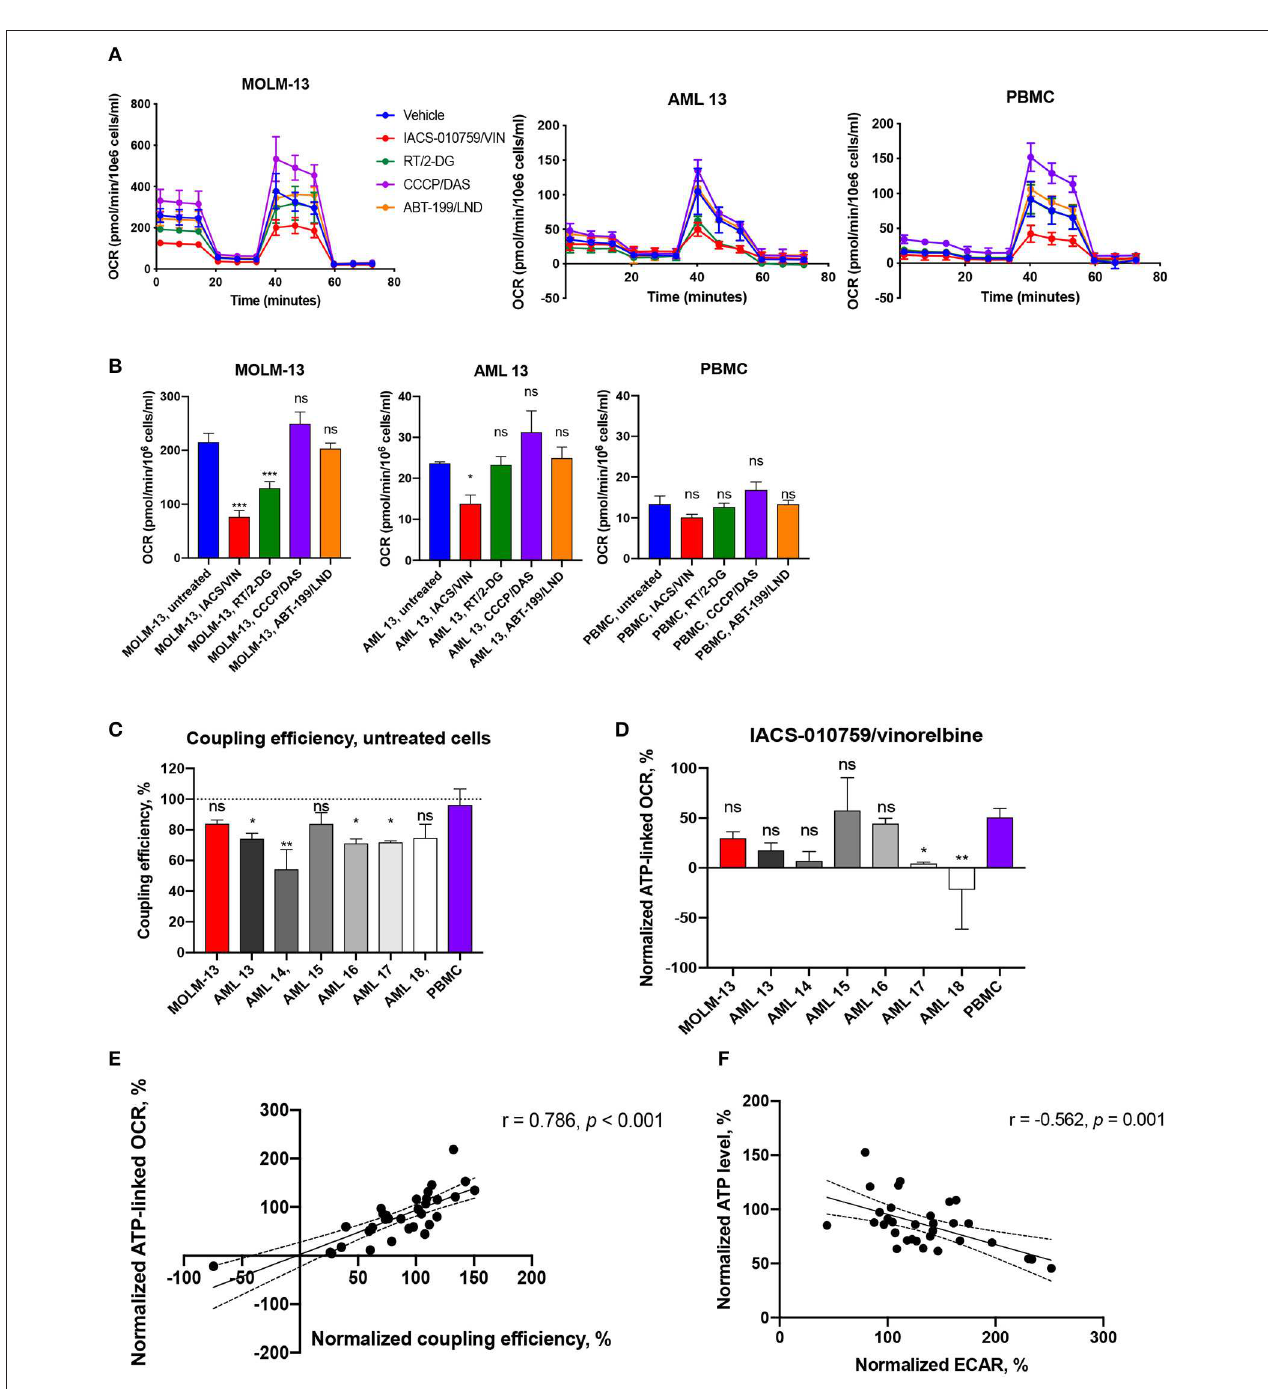
FIGURE 7 | Bioenergetic profiling of immortalized and primary AML cells and healthy PBMCs after treatment with selected drug combinations. (A) Oxygen consumption rate (OCR) was measured using a Seahorse flux analyzer. OCR measured in cells either untreated (blue) or treated with IACS-010759 25 nM/vinorelbine 10nM (red), rotenone 50 nM/2-deoxy-D-glucose 50 µ M (green), CCCP 200 nM/dasatinib 50nM (purple), or ABT-199 1.3 nM/lonidamine 50nM (orange) for 2h. One representative replicate of time-course OCR measurements (mean ± SD) in MOLM-13 cells, representative primary AML sample (AML 13), and healthy PBMCs is shown. See Figure S16 for additional primary cell data. (B) Treatment-induced changes in basal mitochondrial respiration in AML cells (MOLM-13, representative AML sample) or healthy PBMCs. Shown is mean ± SEM. Significance of difference between treated and untreated cells was assessed via ANOVA with subsequent pairwise comparisons. (C) Coupling efficiency of untreated AML cells or healthy PBMCs. Shown is mean ± SEM. Significance of difference vs. PBMCs was assessed via ANOVA with subsequent pairwise comparisons. (D) ATP-linked respiration after IACS/VIN treatment in a panel of AML cells or PBMCs, normalized to